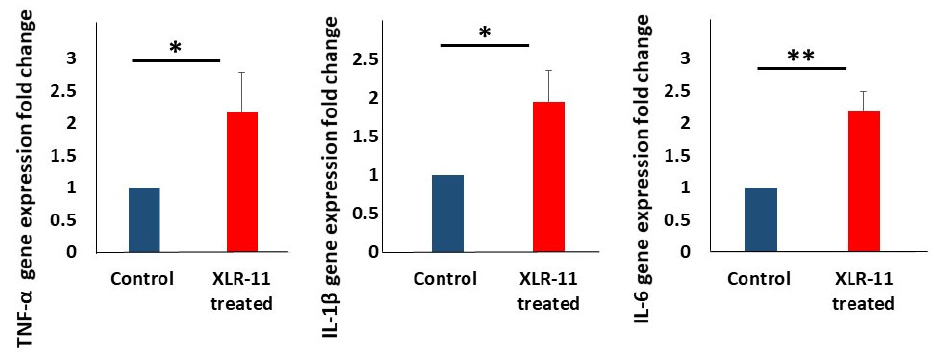
Figure 2. Makers of proinflammatory cytokines TNF- α , IL-1 β , IL-6 in liver of XLR-11 treated mice compared to control mice, * p -value < 0.05, ** p -value < 0.005,